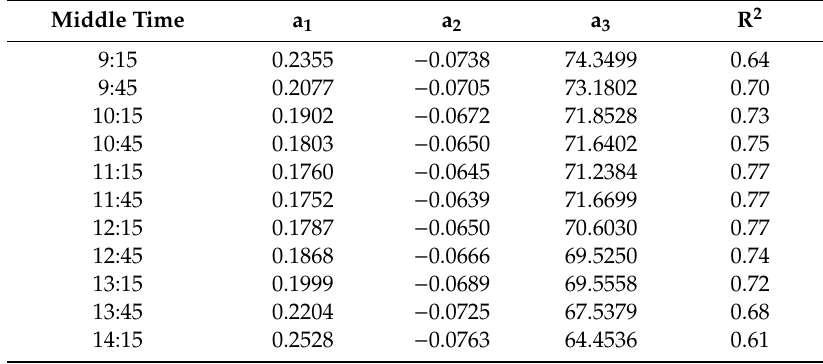
Table A3. Calibrated values of the parameters of the Cdi formulation used in this